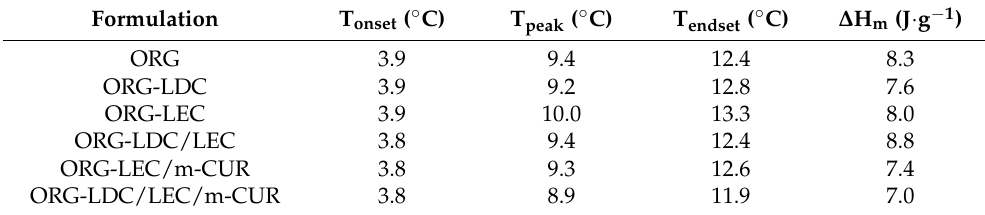
Table 2. Phase transition temperatures (T peak ), together with the initial (T onset ) and final (T endset ) transition temperatures, and the micellization enthalpy variation ( ∆ H m ) for all